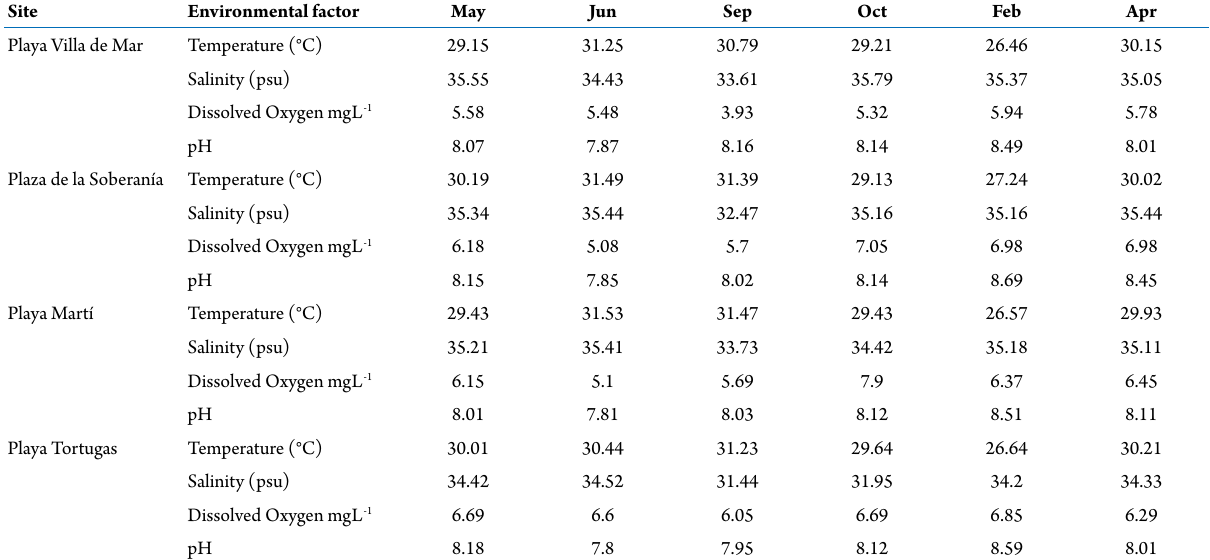
Table 1. Values of environmental parameters measured at the four sites during the study period.